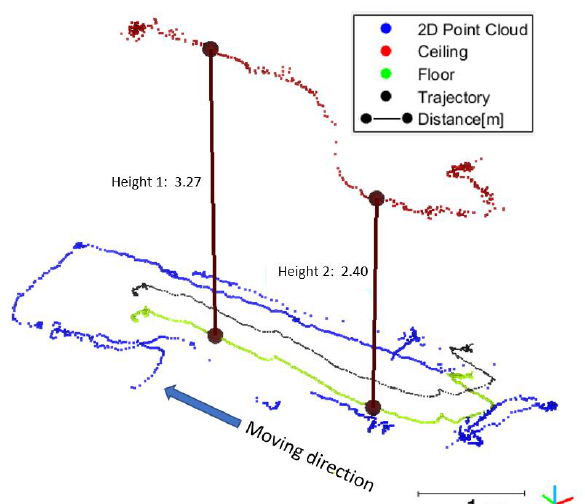
Figure 9 . Crazyflie 2D point cloud map, coloured based on point distance to the TLS map, for the ITC